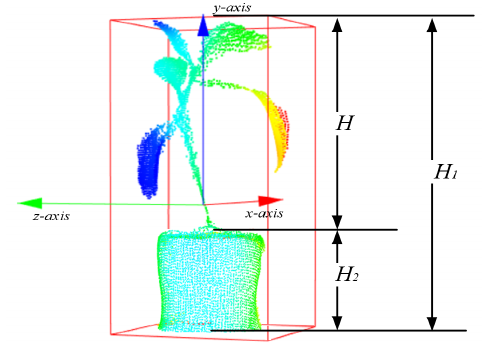
Figure 12. Calculation the plant’s height by vertical distance method based on y -axis.